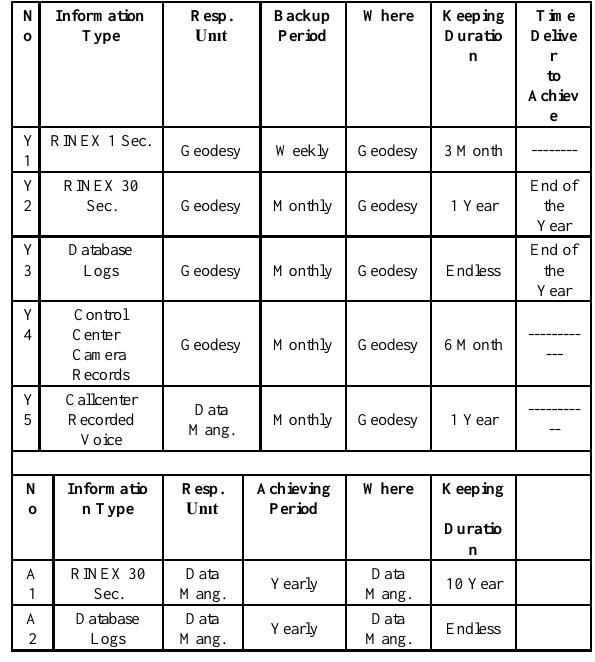
Figure 2-TUSAGA-Aktif Information to be backed up and to be